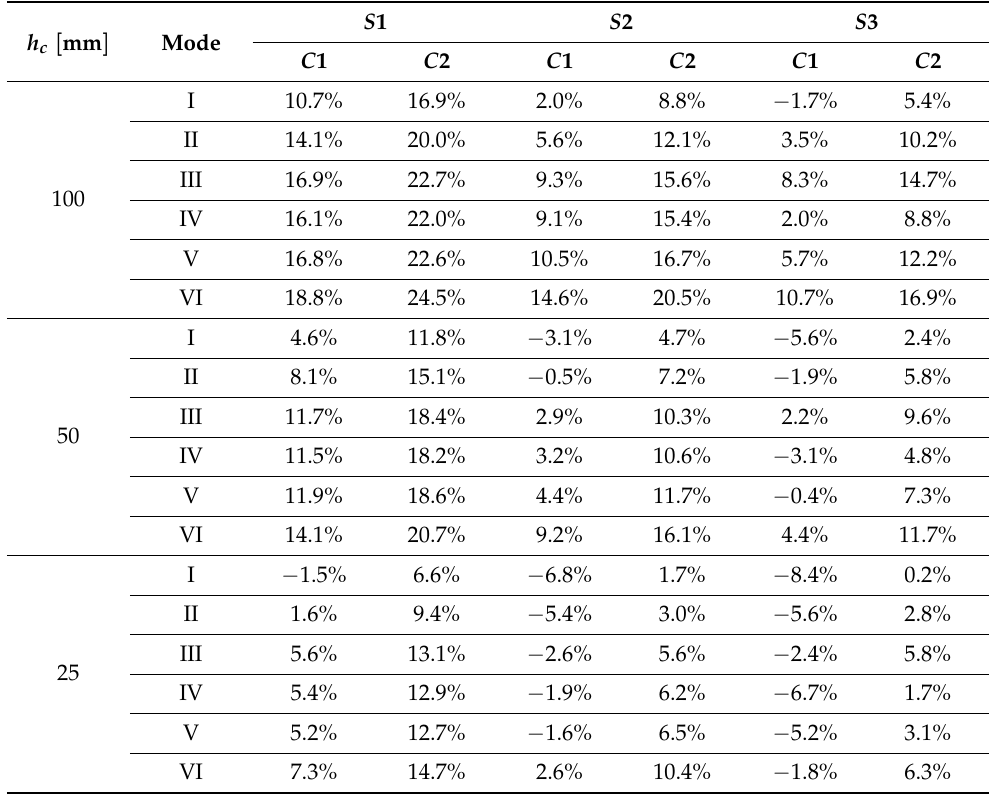
Table 1. The relative errors between averaged models and FEM model for a = 0.005 m.